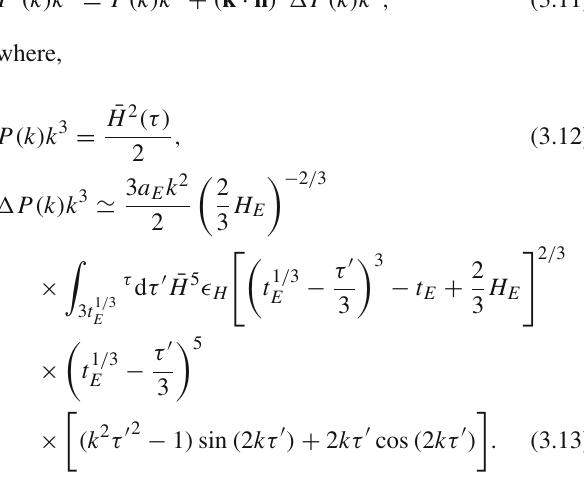
in which we employ the procedure of finding the conju- gate momentas for the foreground and background metrics, (cid:17)(χ) = (cid:17)(χ) = ∂ L (χ, ∂ μ χ)(∂ μ χ) and then the respective Hamiltonian densities H [ χ, (cid:17) ] = ˙ χ(cid:17) − L χ . The interac- tion part Hamiltonian density, H I is the difference in the background from the perturbative